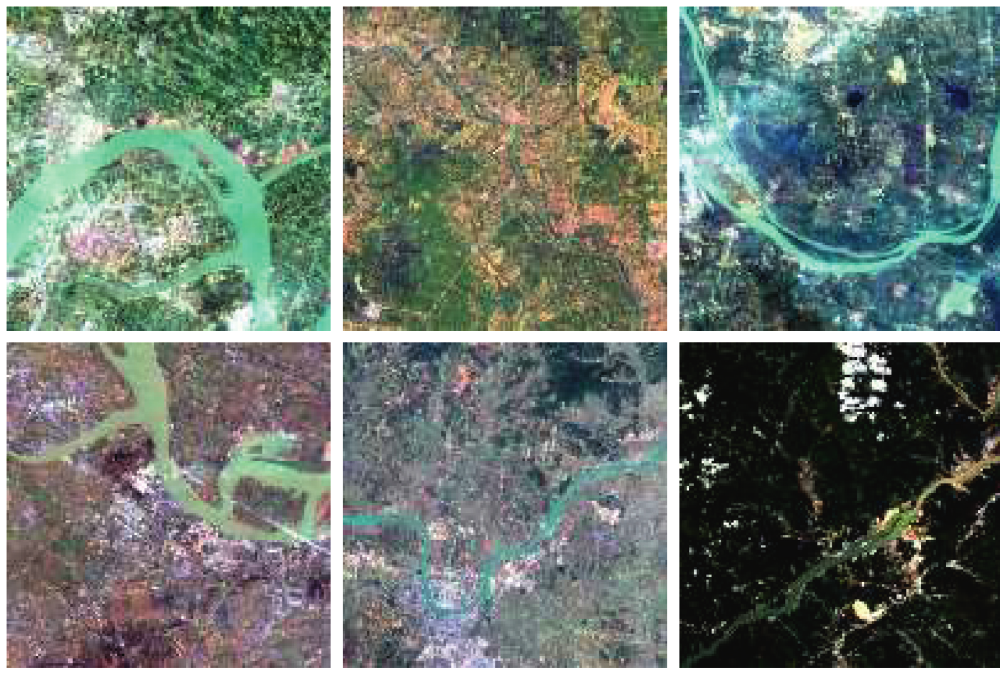
Figure 8: Diversified data set.